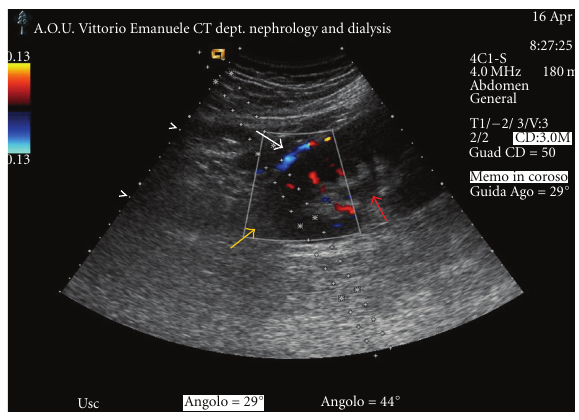
Figure 2: Colour Doppler US examination shows anomalous capsular venous vessel (white arrow) at the inferior pole left kidney (yellow arrow). Red arrow shows renal